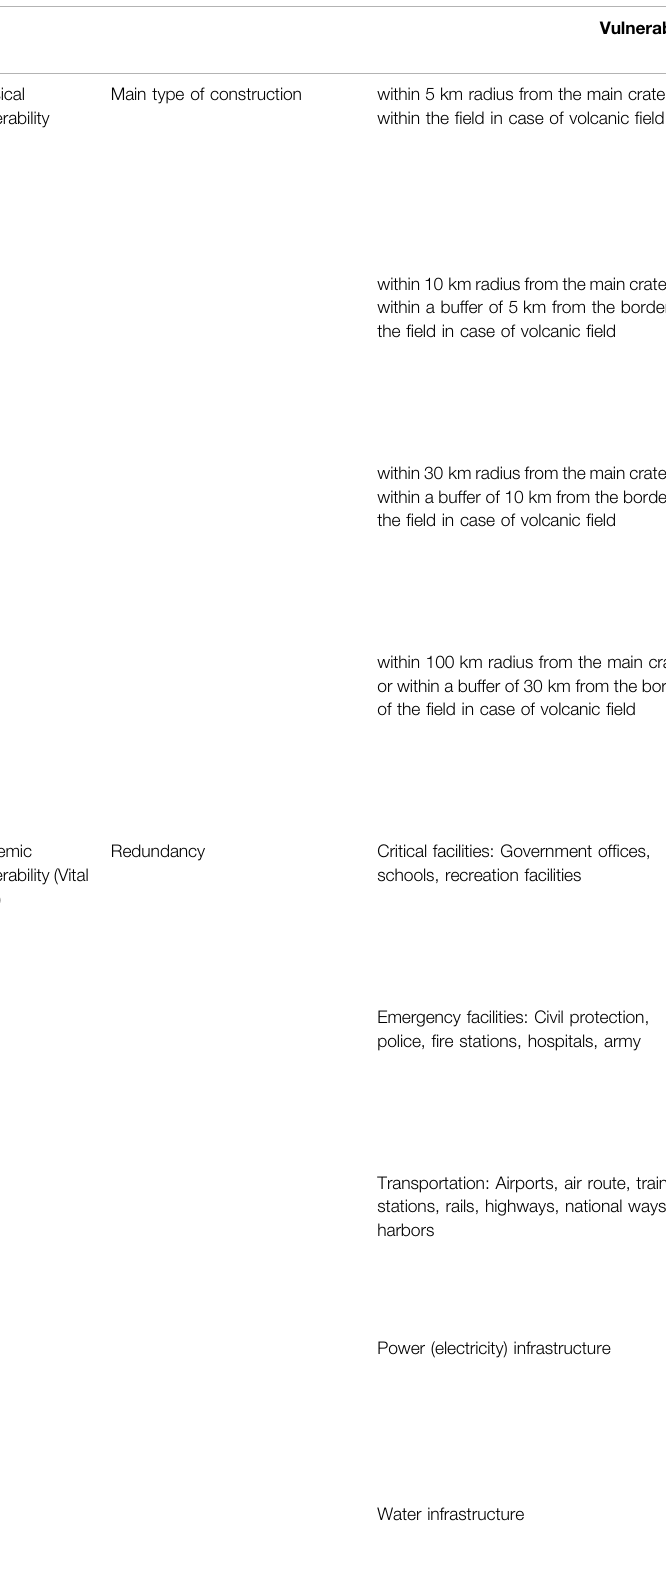
TABLE 3 | Vulnerability parameters evaluated in the new ranking